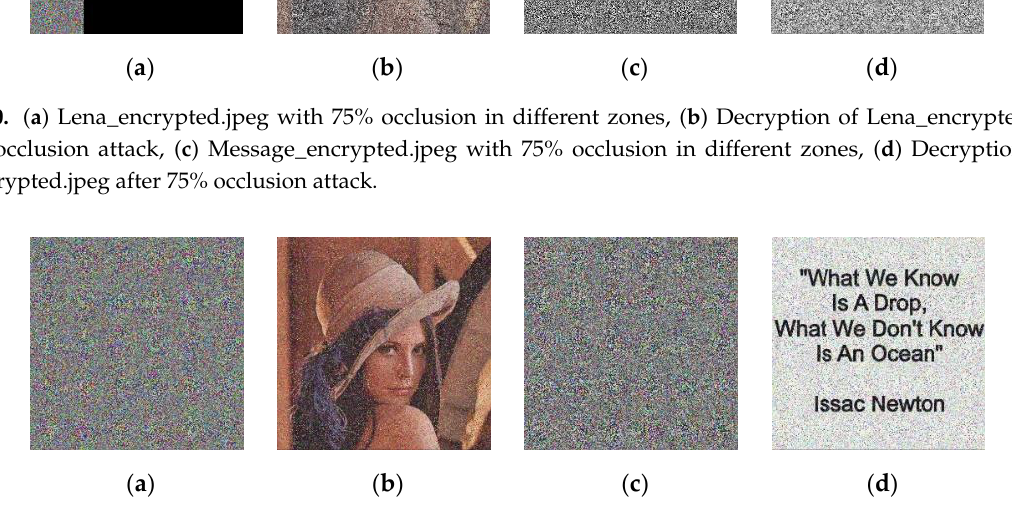
Figure 11. ( a ) Lena_encrypted.jpeg under a salt and pepper noise attack with a density of 25%, ( b ) Decryption of Lena_encrypted.jpeg after noise attack with a density of 25%, ( c ) Message_encrypted.jpeg under a salt and pepper noise attack with a density of 25%, ( d ) Decryption of Message_encrypted.jpeg after noise attack with a density of 25%.